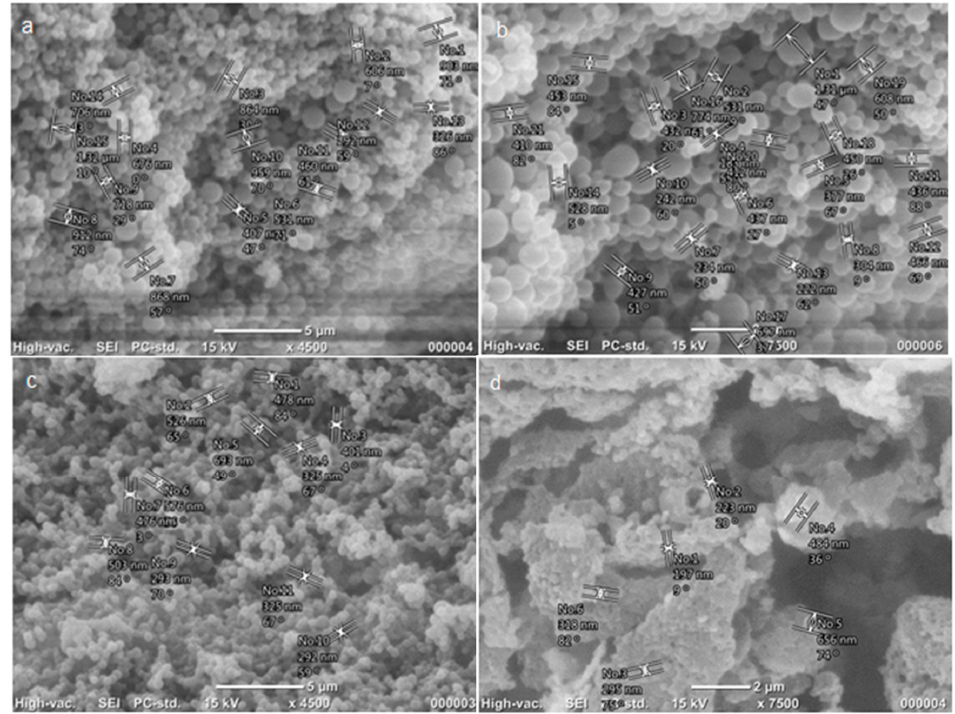
Figure 5. SEM micrographs of prepared nanoparticles ( a ) poly( L -lactic acid) (PLLA)–GAL, ( b ) Figure 5. poly(lactide- co -glycolide) (PLGA) 75/25–GAL, ( c ) PLGA 65/35–GAL, and ( d ) PLGA 65/35–HPC–GAL.